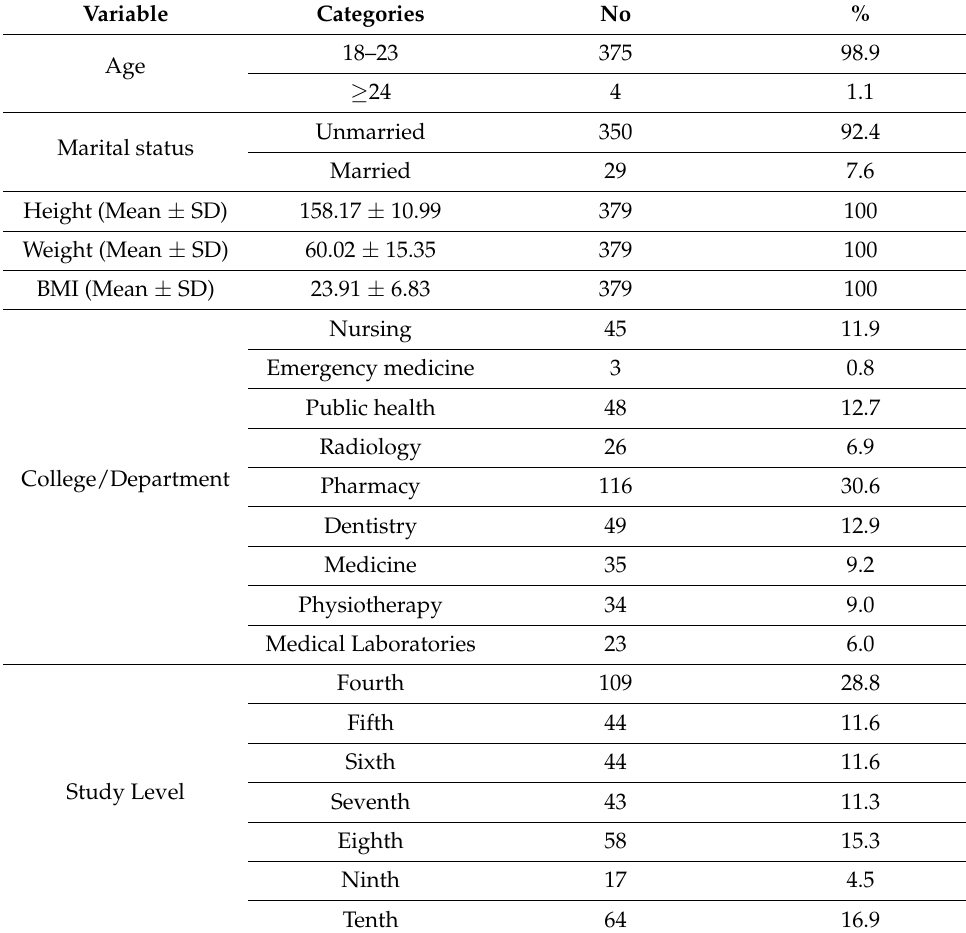
Table 1. Demographic and general information of the study participants (n = 379).